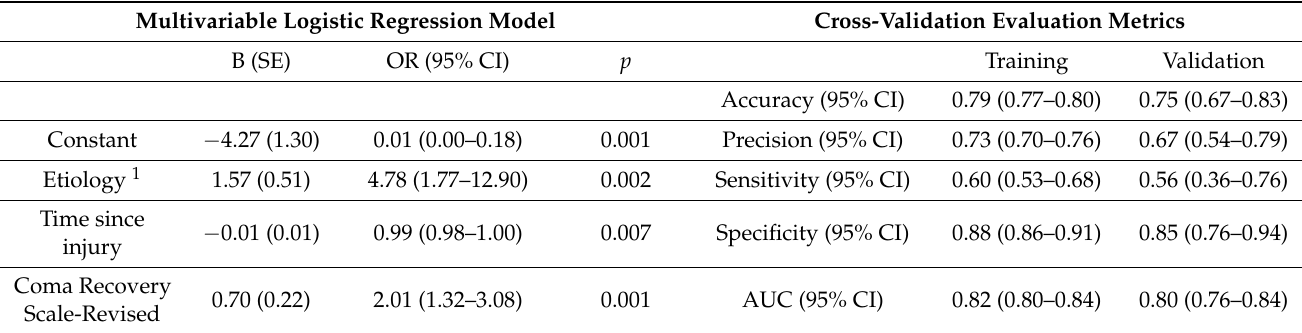
Table 2. Parameters and validation metrics of the predictive model of transition to Minimally Conscious State. Multivariable Logistic Regression Model Cross-Validation Evaluation